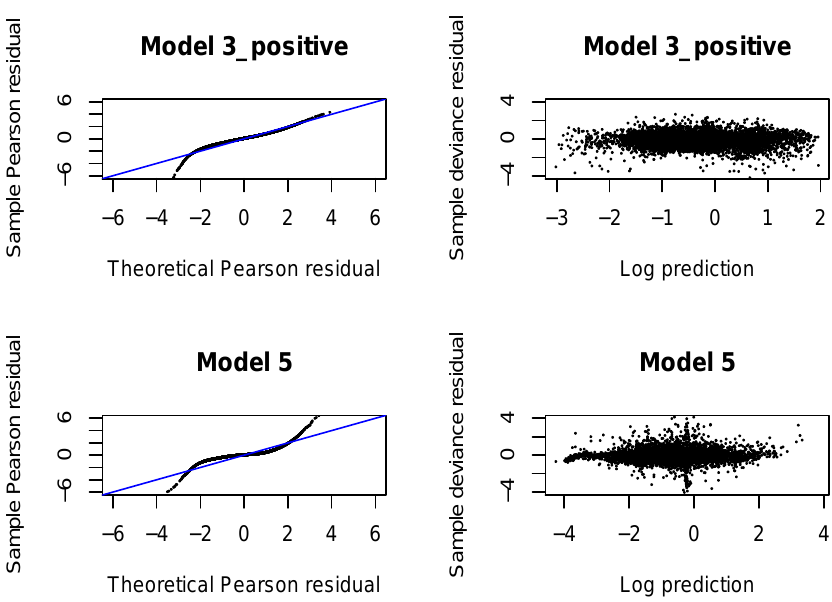
Figure A4. QQ normal plots and Tukey-Anscombe plots in Models 3_positive and 5 fitted with neural